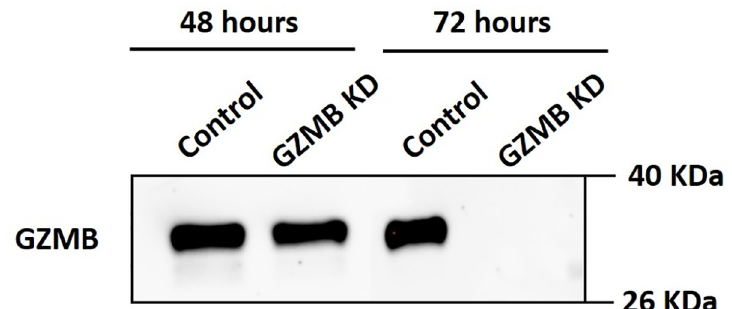
Fig 4. Western blot analysis to detect GZMB in conditioned media from ARCaP-M under negative scrambled siRNA control and GZMB siRNA knockdown (KD) after 48 and 72 hours. These results show the absence of GZMB in ARCaP-M 72 hours after GZMB knockdown and thus the 72-hour time point was selected for further investigations.